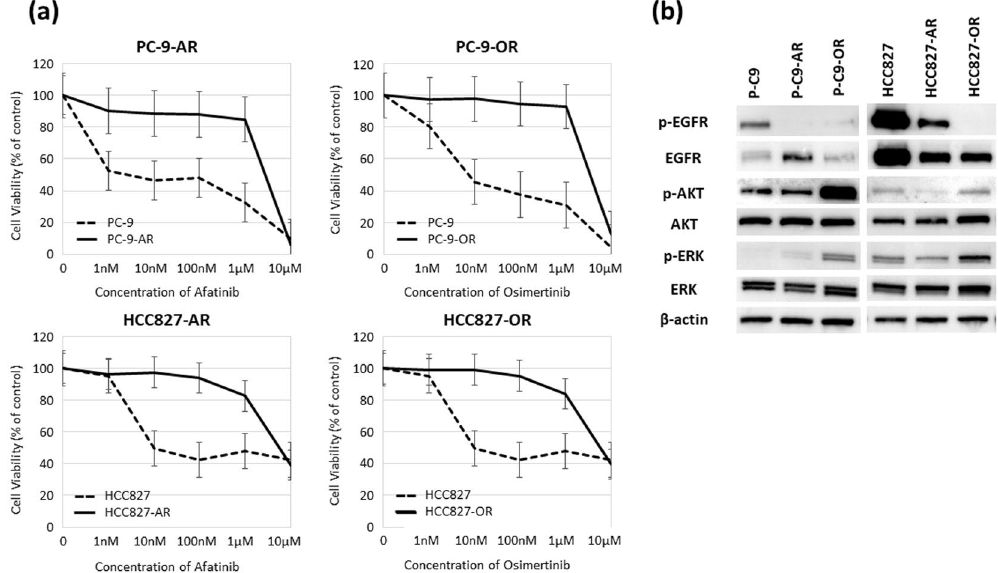
Figure 1. Establishment of afatinib- and osimertinib-resistant PC-9 and HCC-827 cells. ( a ) PC-9-afatinib- resistant cell line (PC-9-AR); PC-9-osimertinib-resistant cell line (PC-9-OR); HCC827-afatinib-resistant cell line (HCC827-AR); and HCC827-osimertinib-resistant cell line (HCC827-OR). The results of cell viability assays are shown. ( b ) Protein expression levels of EGFR signal pathway